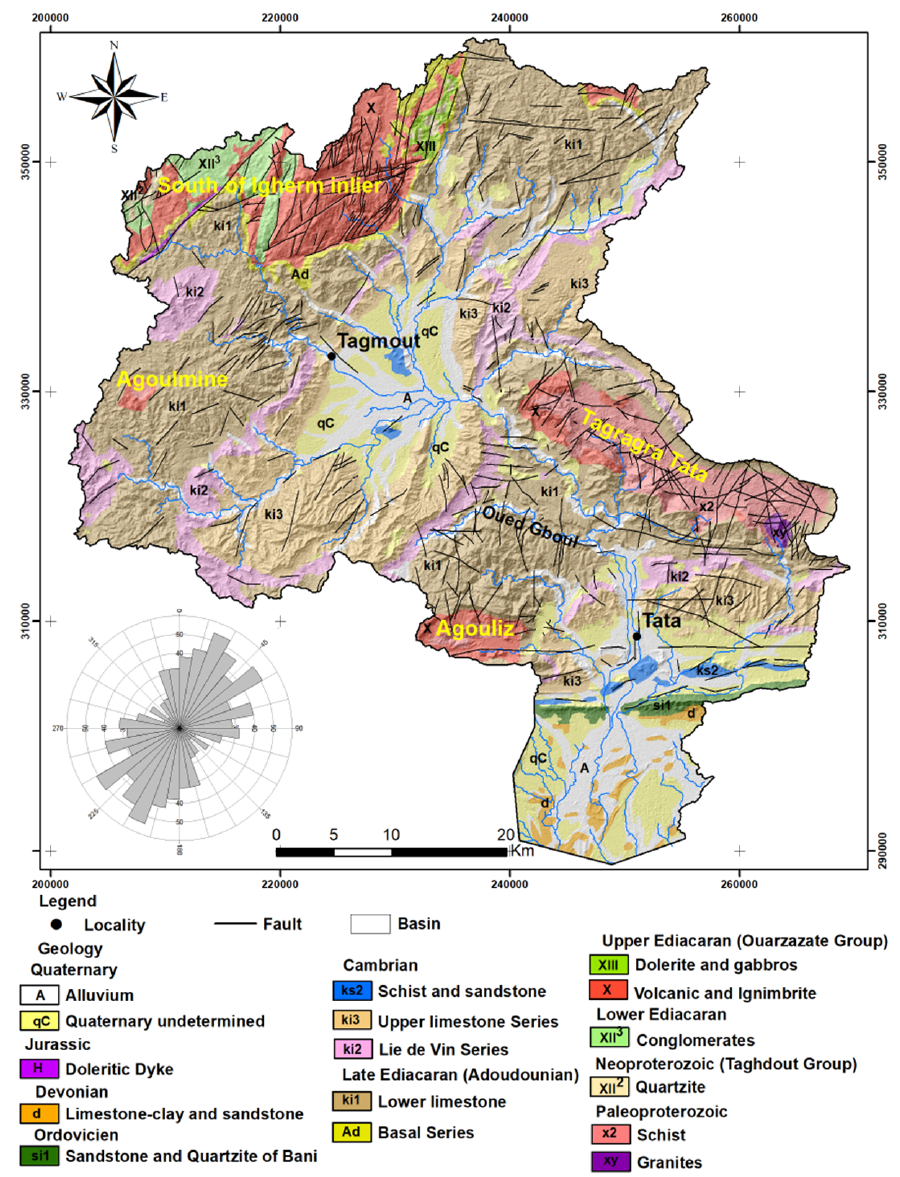
Figure 3. Geological map of the Tata basin.